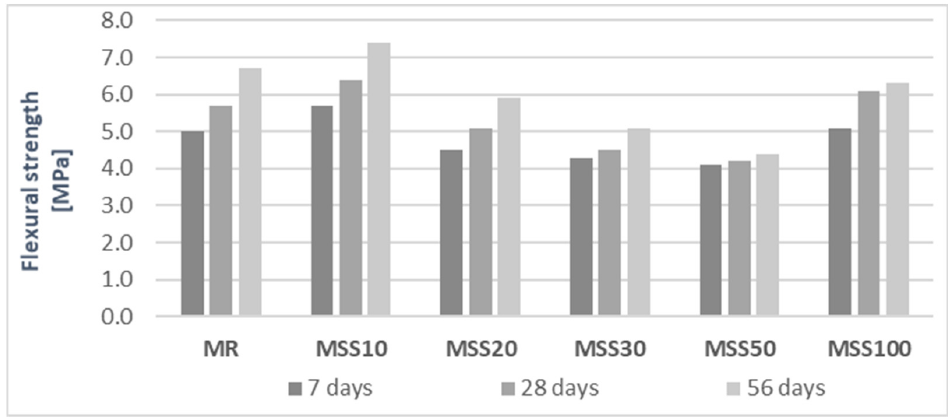
Figure 11. Flexural strength of mortars after 7, 28, and 56 of maturation.